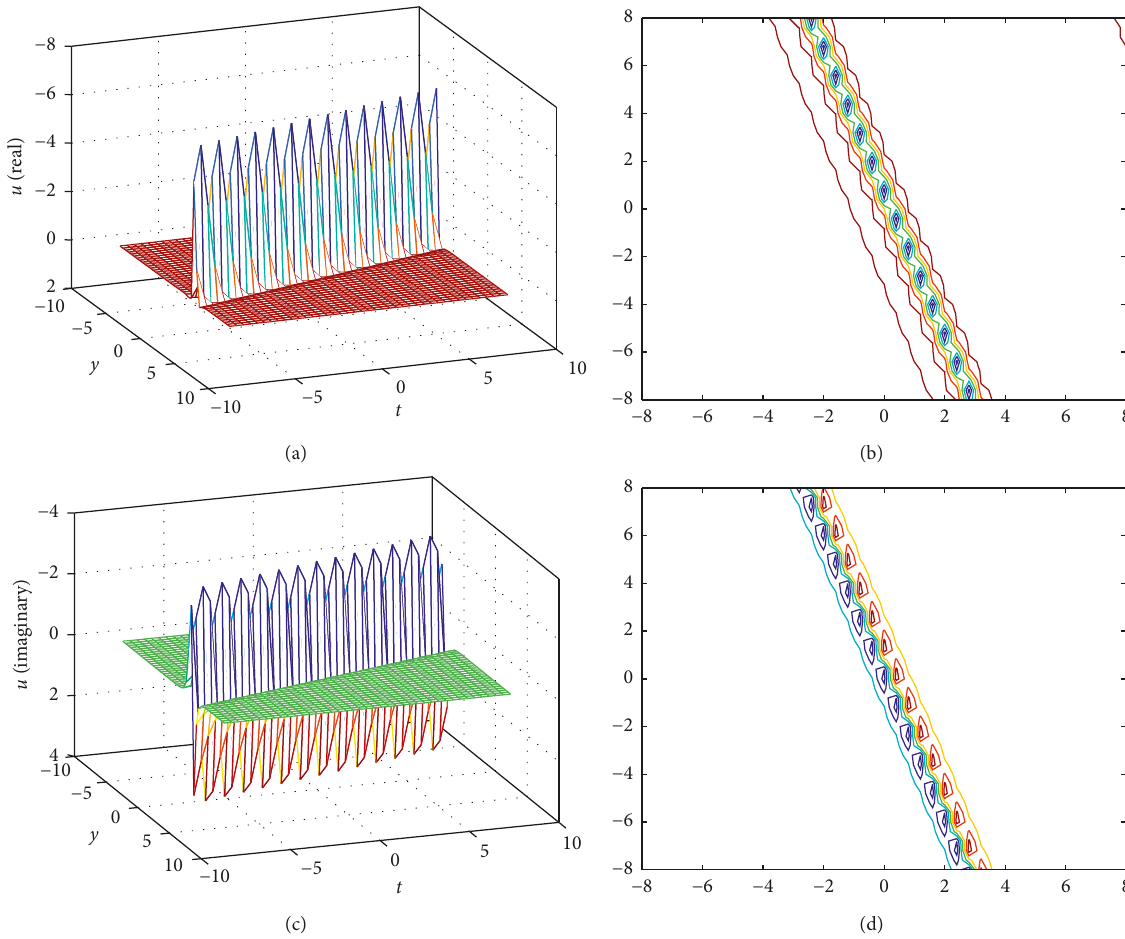
Figure 5: Plots of interaction solutions (19) with b the imaginary part of u ; (d) contour map of the imaginary